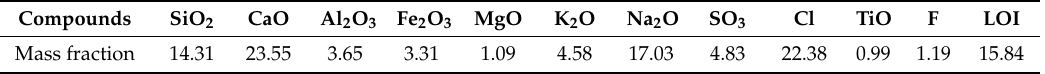
Table 1. Main compounds in medical waste incinerator fly ash MWIFA.